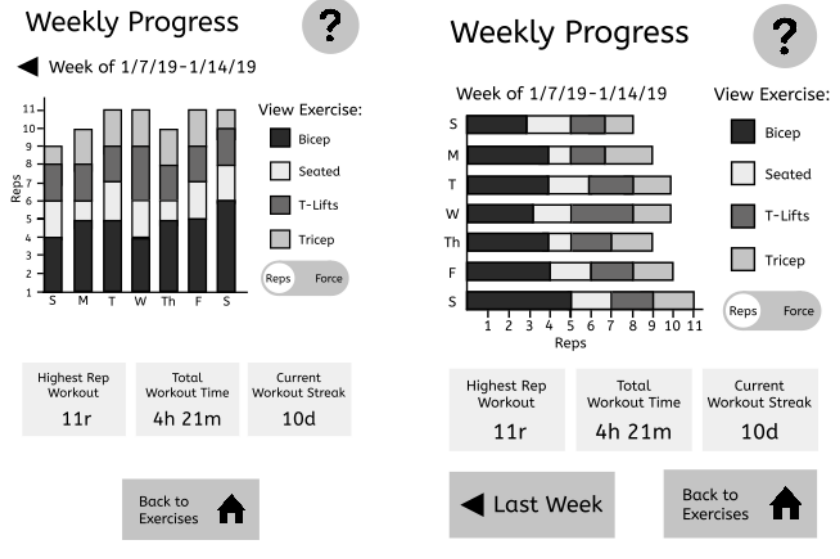
Figure 2. The App version for round 2 also had two different versions of the weekly progress screen shown to participants in random order.